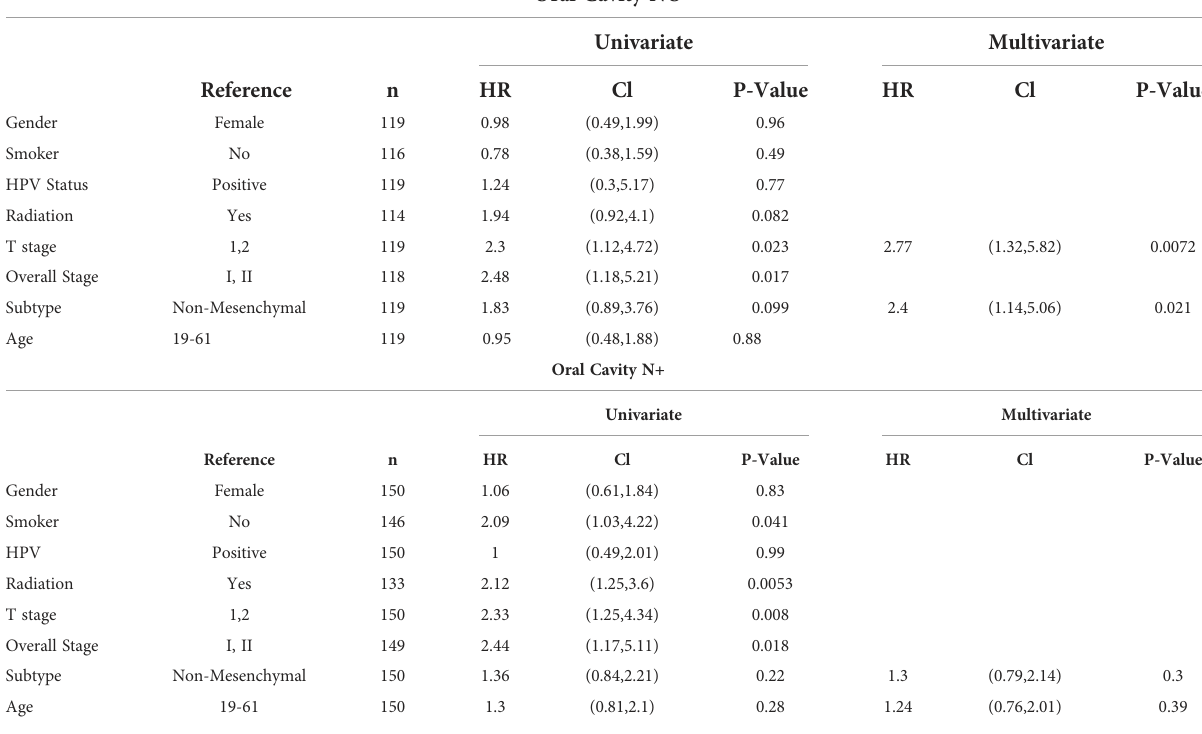
TABLE 2 Univariate and multivariate survival analysis within Oral Cavity N0 and N+ subgroups.